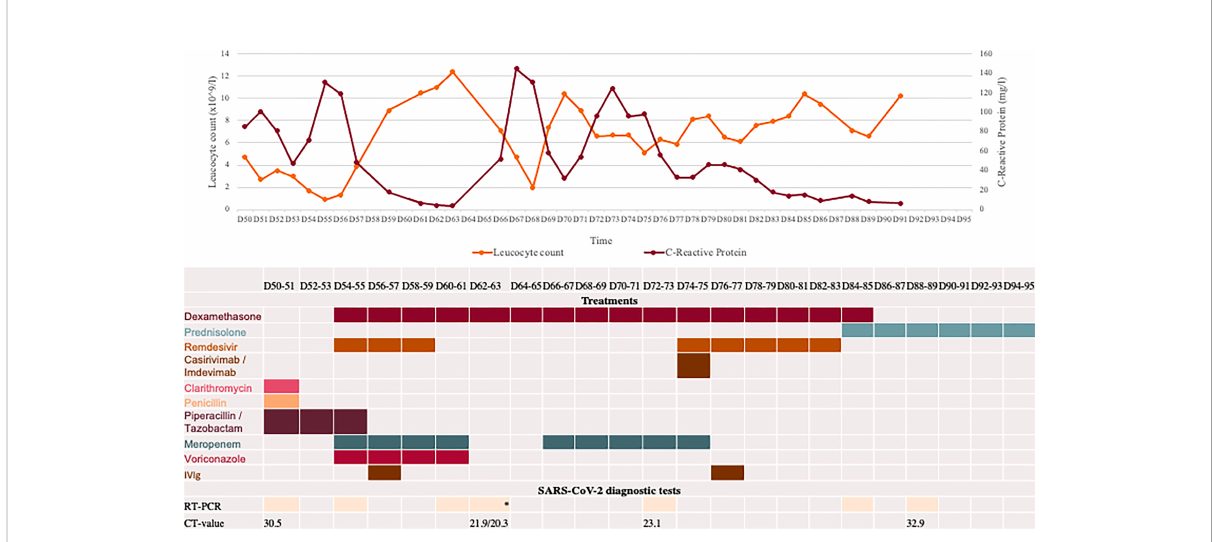
FIGURE 1 Overview of blood test, COVID-19 diagnostic analyses, and medications during second hospital admission starting at day 50 (D50) after fi rst positive SARS-CoV-2 test. All RT-PCR tests were positive for SARS-CoV-2 B.1.617.2 (Delta variant) performed on material from nasopharyngeal swab, except *two tests performed on BAL material. PIT: piperacillin/tazobactam. Cut-off for positive SARS-CoV-2 PCR is a Ct value of 38. Pip/ Tazo, piperacillin/tazobactam; IVIG, intravenous immunoglobulin; Casirivi/Imdevi,